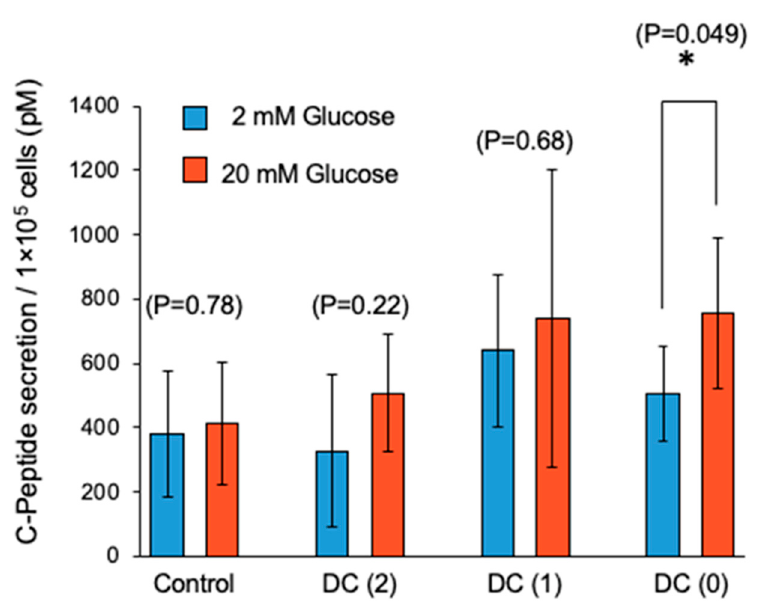
Figure 6. Glucose-stimulated C-peptide secretion of differentiated islet-like cells in second phase glucose stimulation. Data represent mean ± SD of n = 5–6 from two independent experiments. Statistical analysis as determined by Student’s t -test. (* p < 0.05).